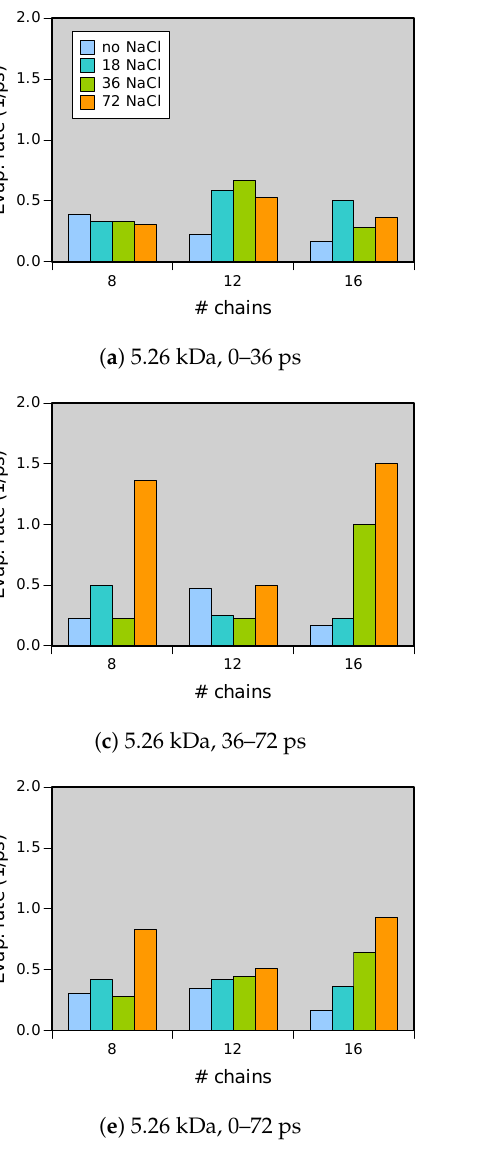
Figure 23. The average rates of evaporation of water molecules under 1.5 V/nm through the indicated intervals of production time: 0–36 ps (first row), 36–72 ps (second row), and 0–72 ps (third row). Left column—5.26-kDa chains, right column—10.55-kDa chains. Results for different numbers of PEG chains (horizontal axis) and different numbers of NaCl ion pairs (colors in the legend) are shown. Each bar represents a result of a single production trajectory. Graphs made by Gnumeric